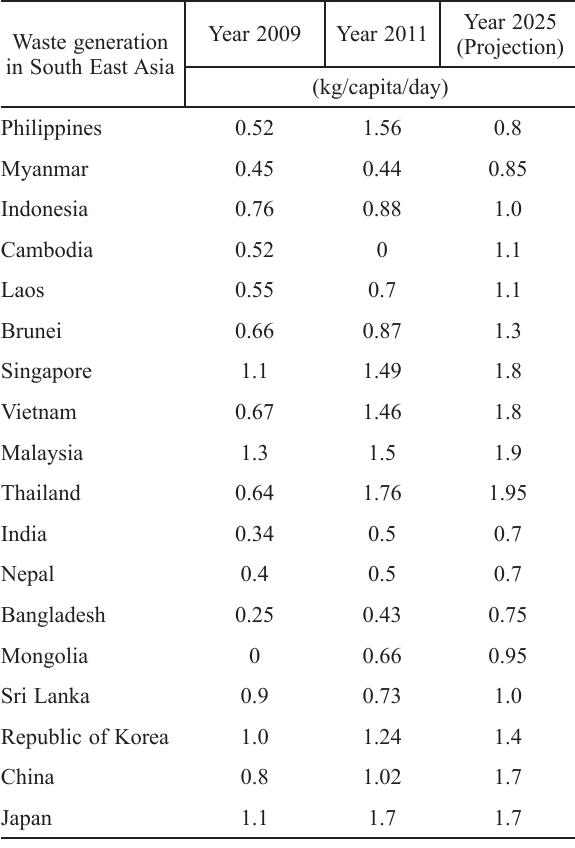
Table 1 – Comparison of waste generation rate among Asia Pacific countries from 2009 to 2025 (Projection) Waste generation in South East